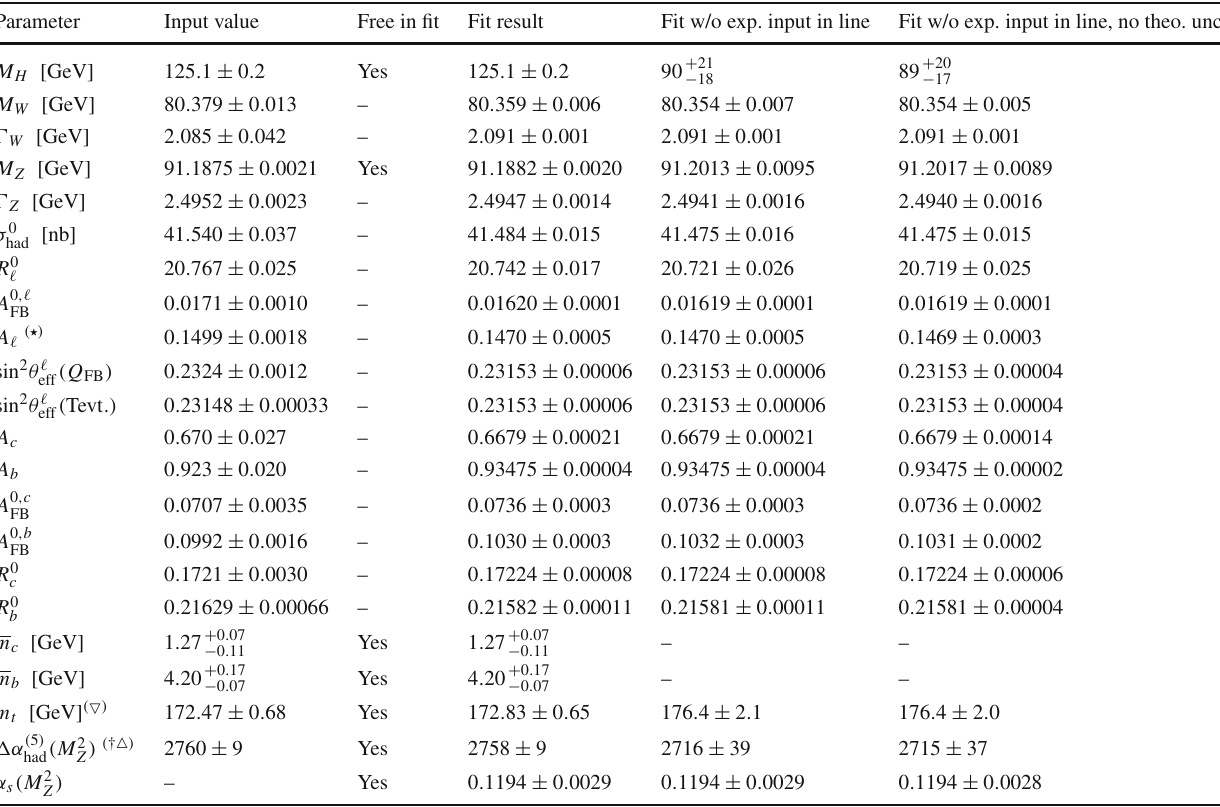
Table 1 Input values and fit results for the observables used in the global electroweak fit. The first and second columns list respectively the observables/parameters used in the fit, and their experimental val- ues or phenomenological estimates (see text for references). The third column indicates whether a parameter is floating in the fit. The fourth column gives the results of the fit including all experimental data. In the